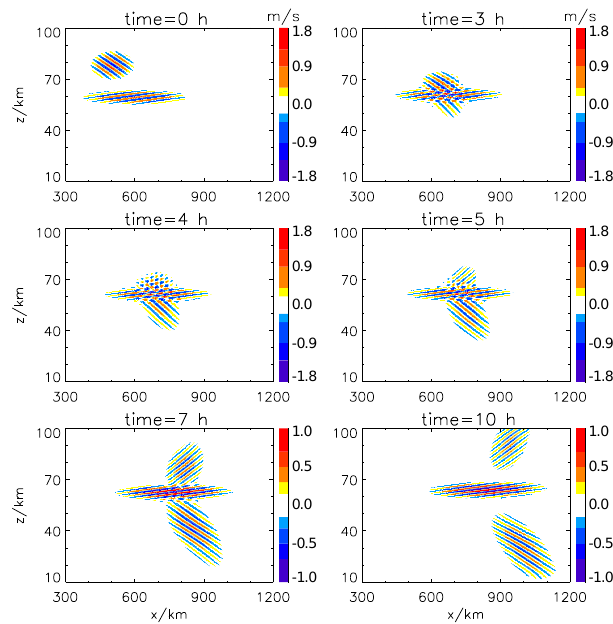
Fig. 2. Wave-wave nonlinear interaction in a nonisothermal atmo- sphere by using square root density-weighted horizontal velocity